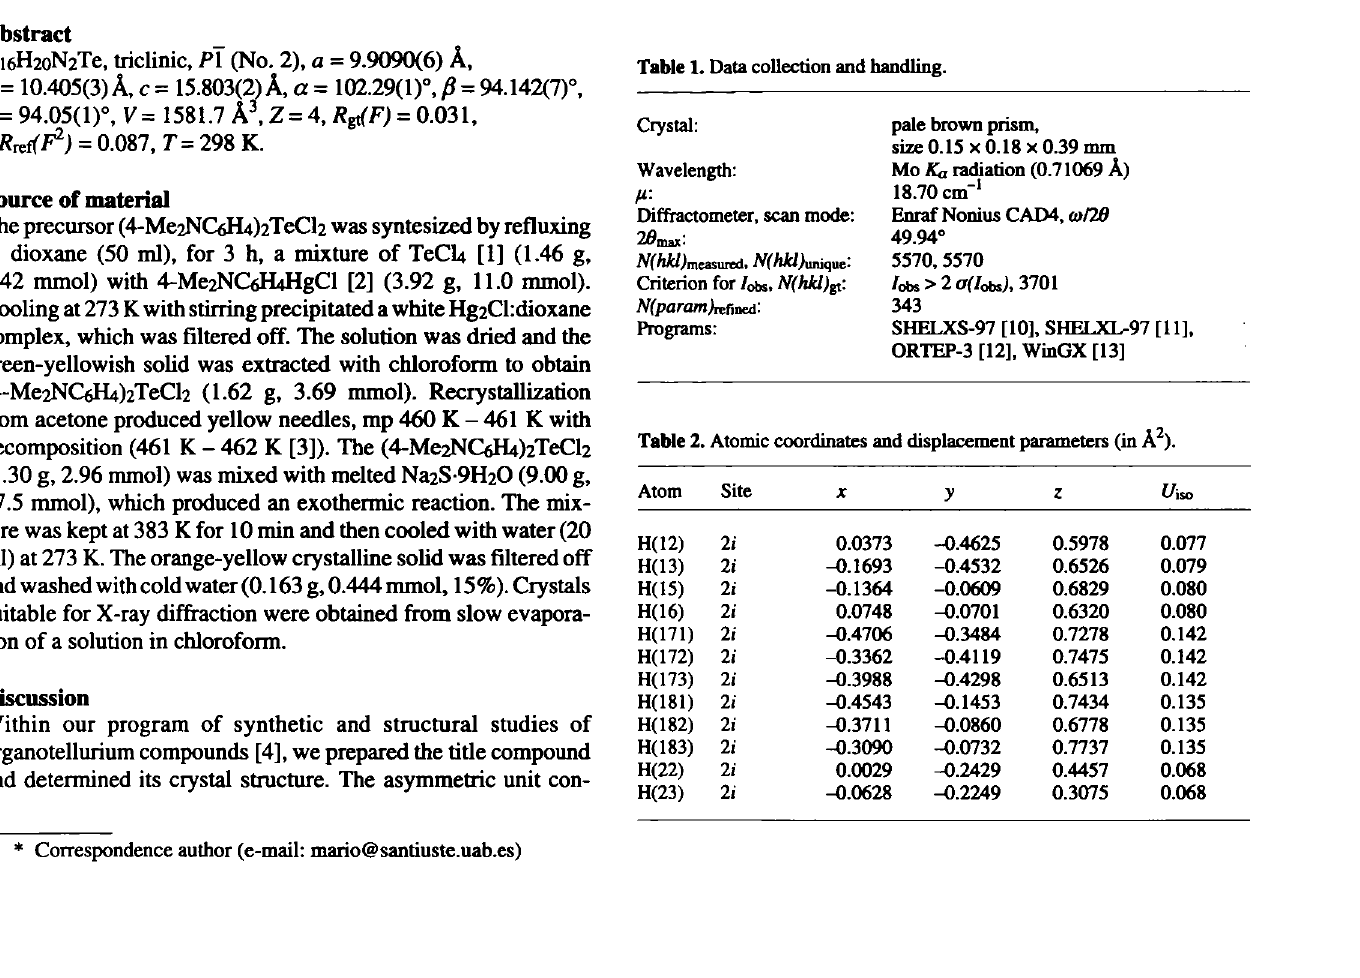
Table 1. Data collection and handling.